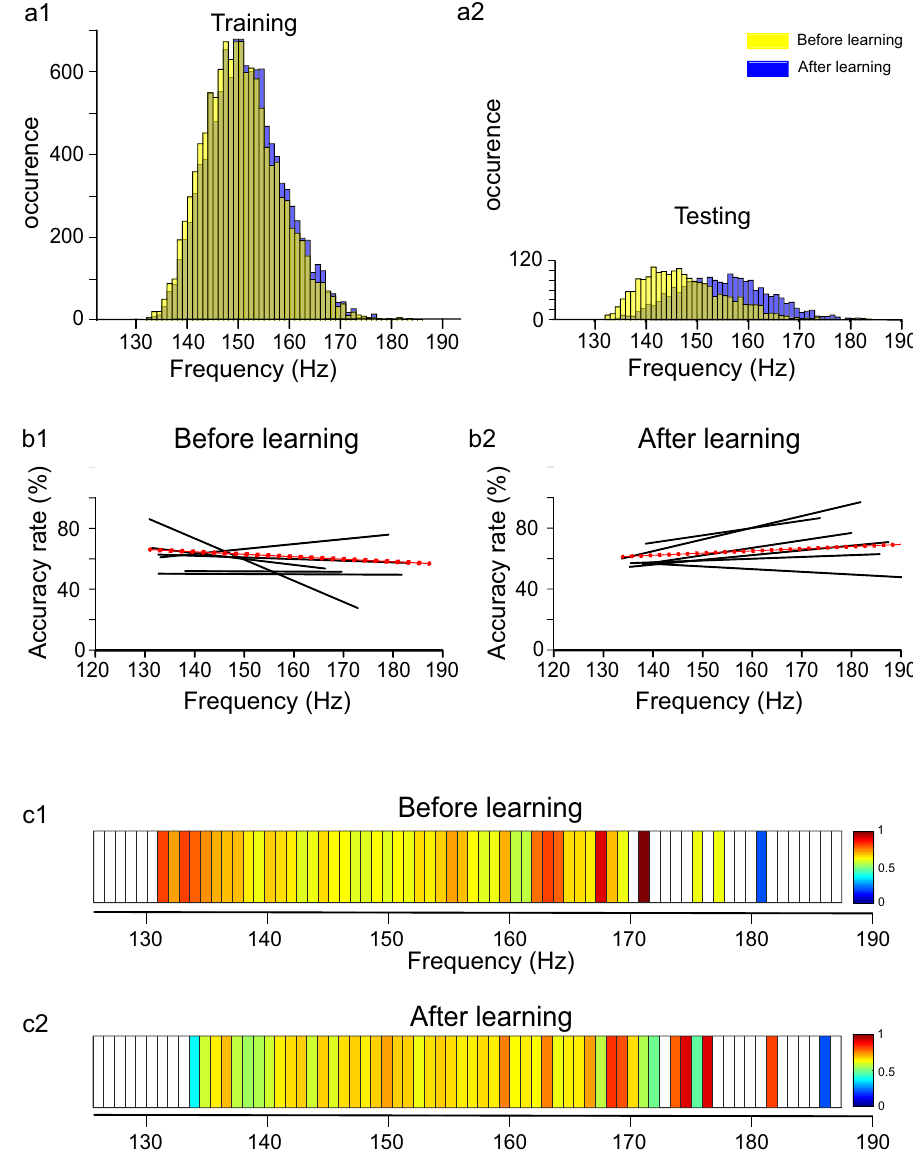
Figure 5. Equalizing distributions of the pre-and post-learning SWRs’ frequency in the training pool induces a new discrimination strategy in the WT group. When the SWRs’ frequency was chosen to have similar distribution before and after learning in the training ( a1 ) but not in the testing pool of RCIs ( a2 ) no correlation with RCI’s accuracy rate was expressed neither in individual animals ( b1–2 ) nor in the pooled set of RCIs ( c1– 2 ), indicating not-frequency based classification of RCIs. Notice flattering of regression lines in b1-2 compared to Fig. 3 and color code bars in c1-2 indicating accuracy rate independent of SWR’s frequency. Abbreviations as in Fig.